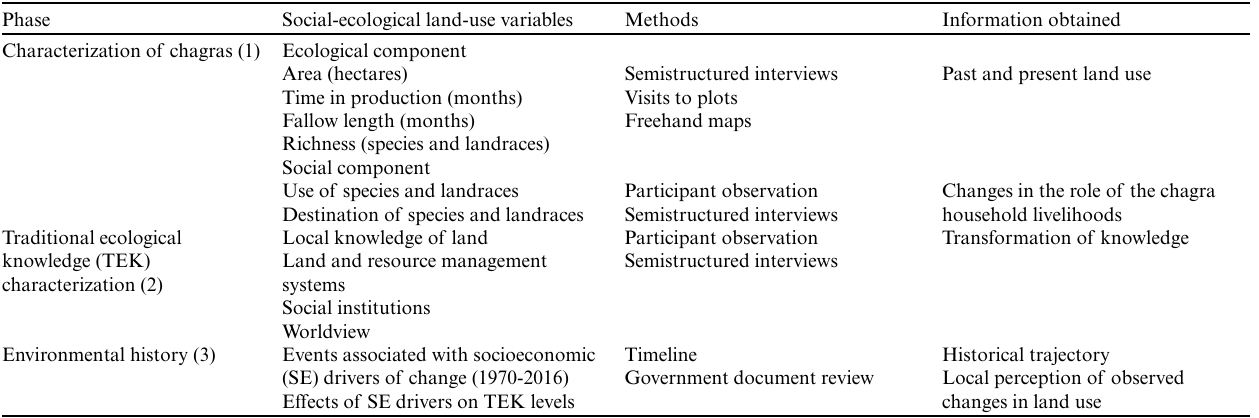
Table 1 . Summary of research